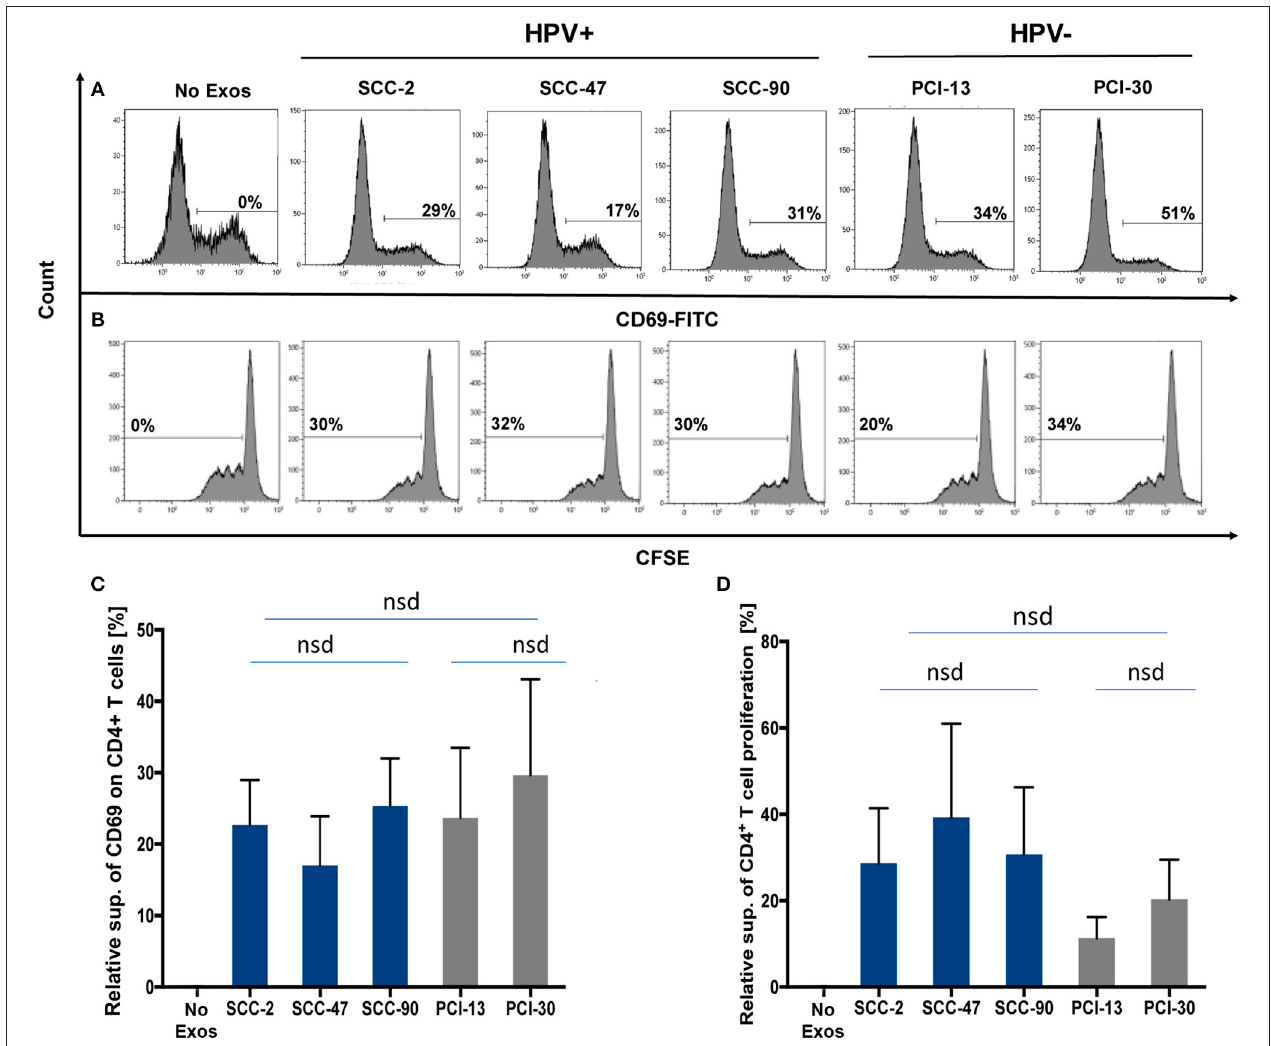
FIGURE 4 | Co-incubation of HPV( + ) or HPV( − ) exosomes with primary lymphocyte subpopulations. (A) Representative flow cytometry data for exosome-mediated inhibition of CD69-expression levels on the surface of human activated CD4 + T cells (top row). (B) Representative data for suppression of CFSE-labeled CD4 + T cell proliferation (bottom row). (C) The data for relative suppression of CD69 expression levels on T cells, and in (D) of T cell proliferation by exosomes isolated from HPV( + ) and HPV( − ) exosomes are compared. The data in (C,D) are means ± SD for 3 experiments performed with exosomes isolated from supernatants of each of the 5 HNC cell lines studied. nsd, no significant